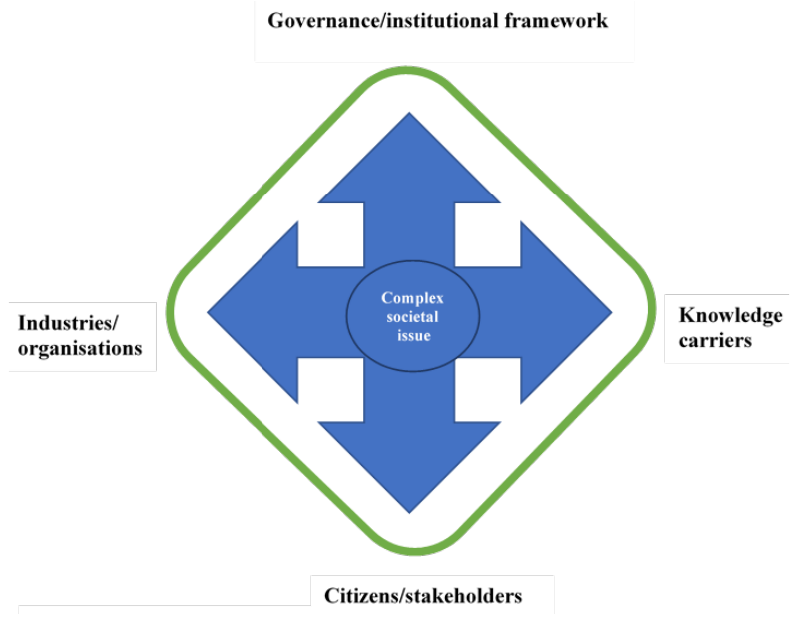
Figure 1. A quadruple helix.